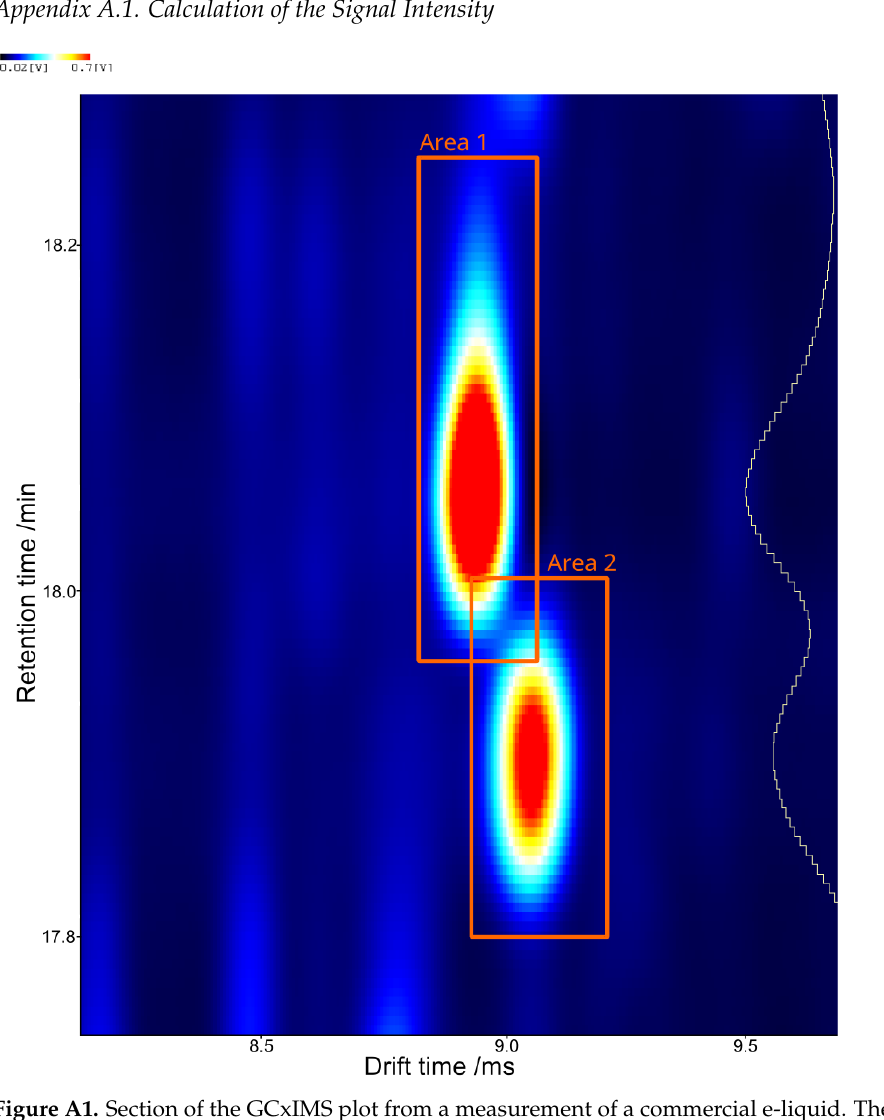
Figure A1. Section of the GCxIMS plot from a measurement of a commercial e-liquid. The marked Areas (Area 1, Area 2) were inserted using the Software VOCal from G.A.S. mbH for the interpretation of GCxIMS data. Both peak maxima are separated, and the peaks should not influence each other. However, the marked areas that are used to calculate the volume of each peak include parts of the other peak and therefore distort the quantification using this